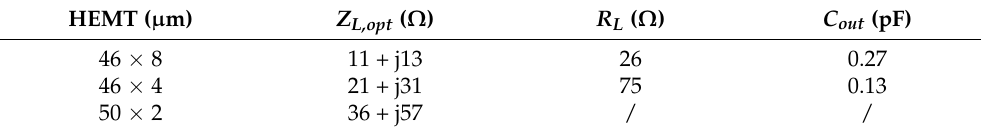
Table 2. Optimal load impedances and the values of large-signal output matching models. HEMT ( µ m) Z L,opt ( Ω ) R L ( Ω ) C out (pF) 46 × 8 11 + j13